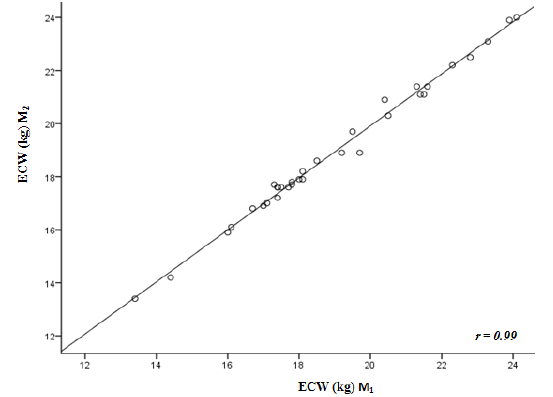
Figure 13. Correlation between the values of param- eters measured by Nutriguard-M before and after the intake of fluids – extracellular water (kg)